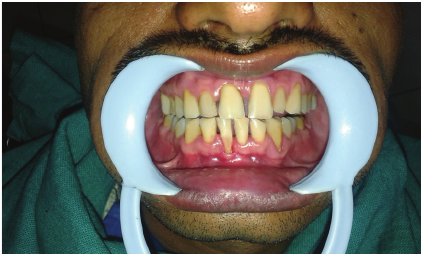
Figure 4: Tunnel preparation.